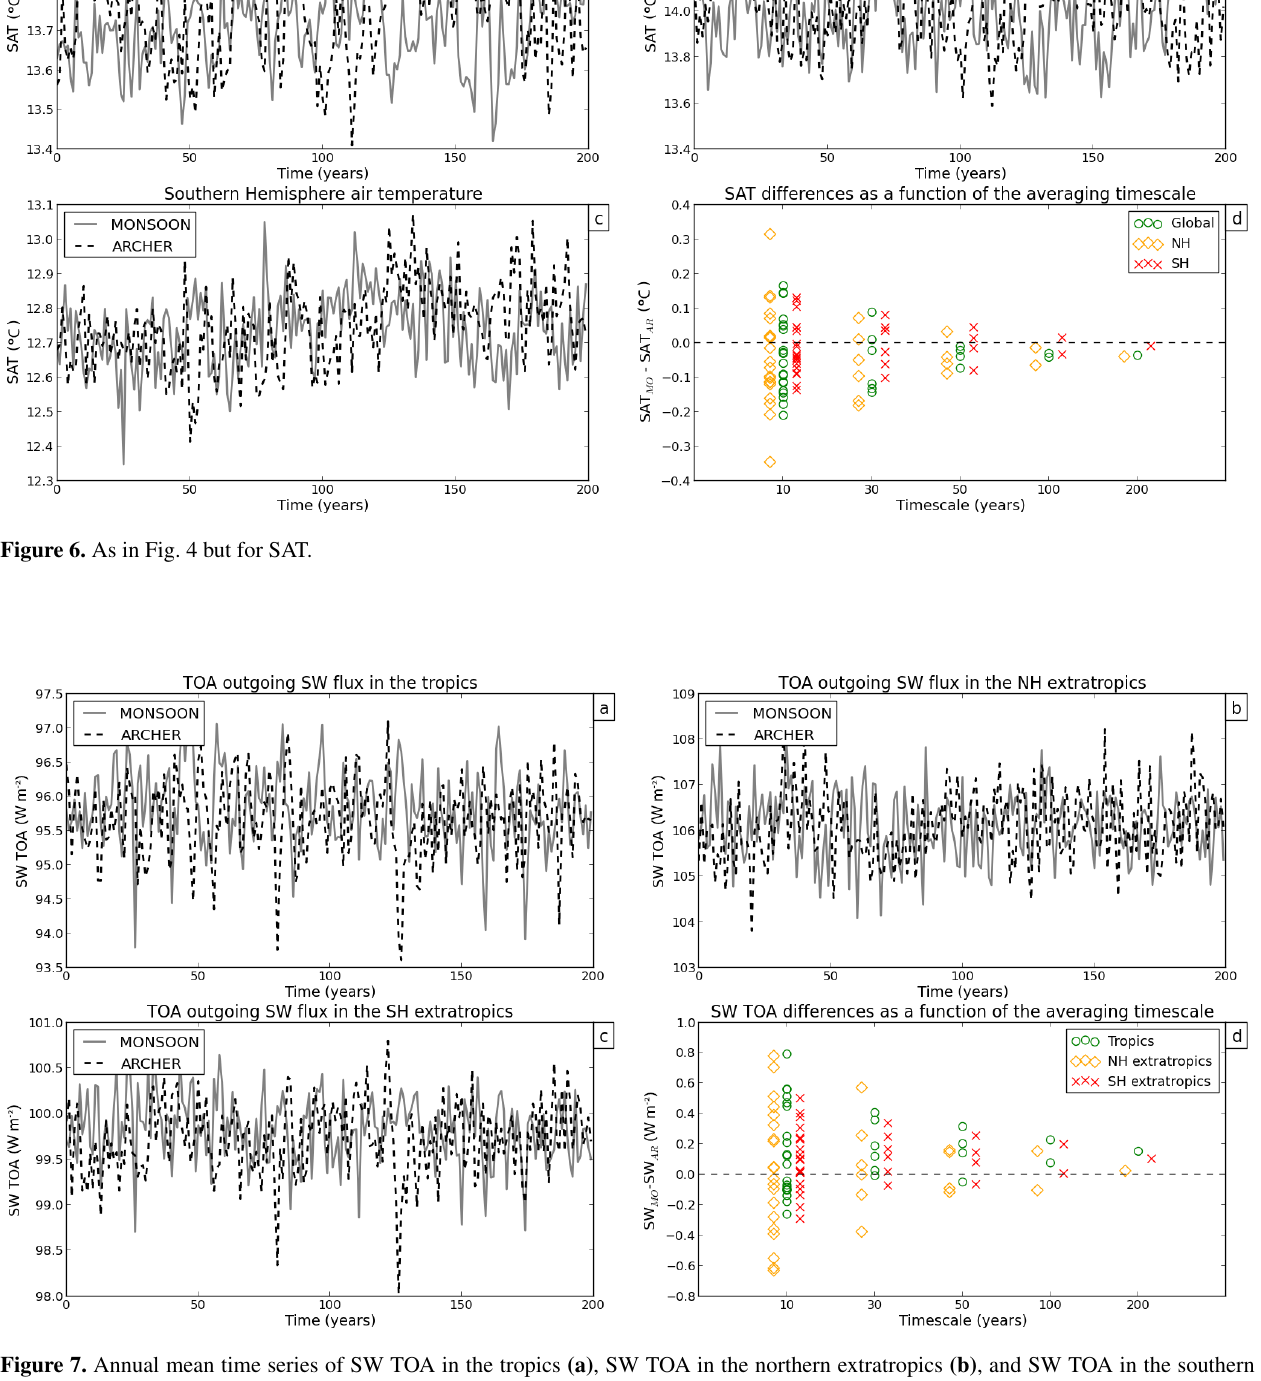
Figure 7. Annual mean time series of SW TOA in the tropics (a) , SW TOA in the northern extratropics (b) , and SW TOA in the southern extratropics (c) for PI MO (grey line) and PI AR (dashed line). Panel (d) shows how SW TOA differences vary as a function of the